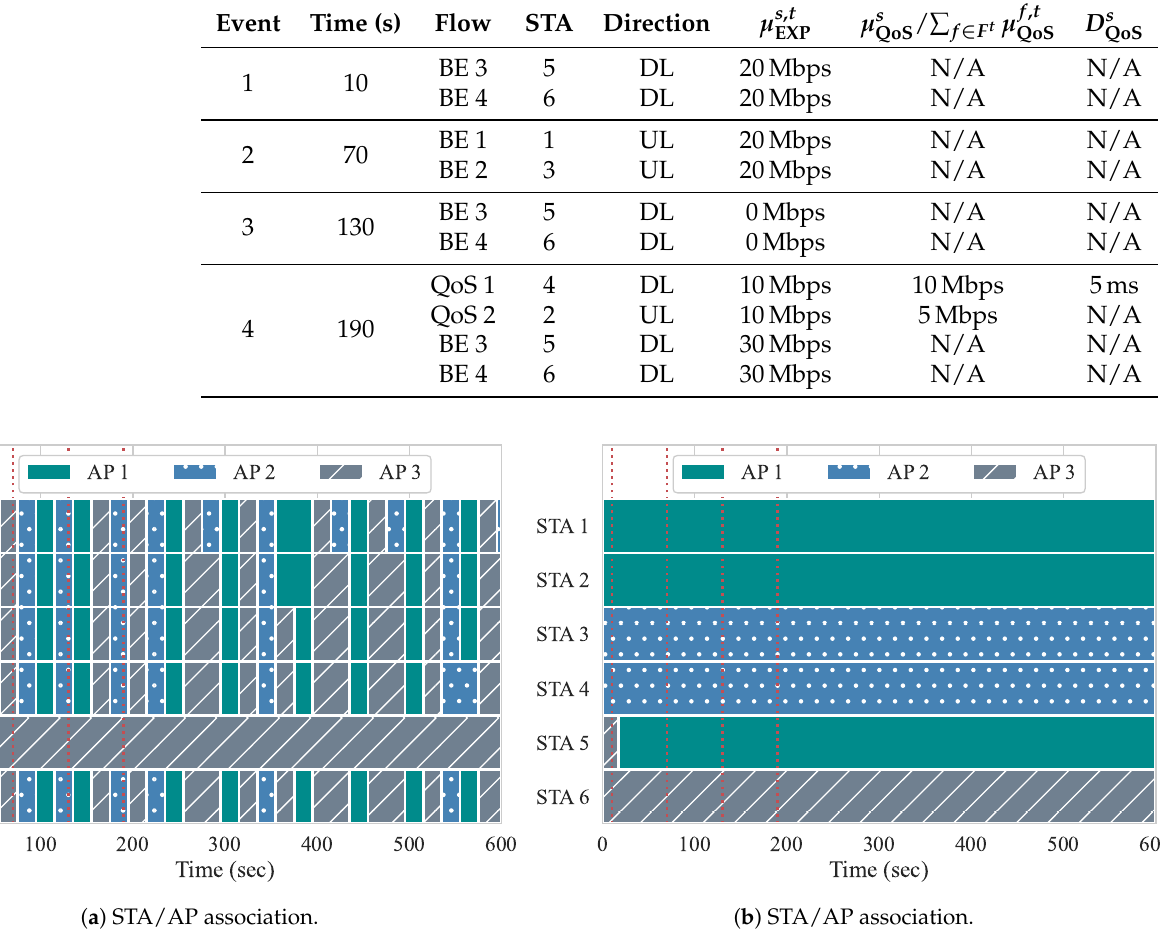
Figure 15. Experiment 3 association. ( a ) Gómez et al. [5]; ( b )